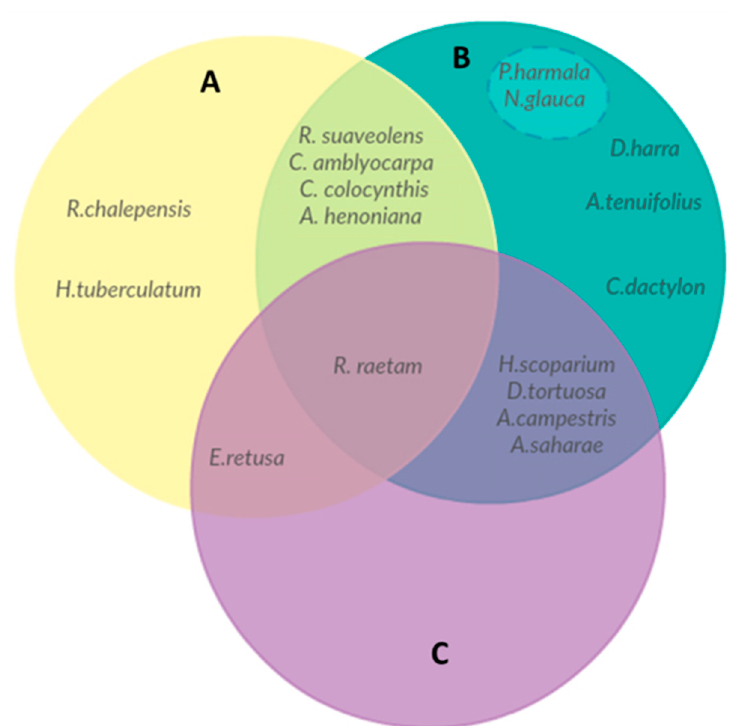
Figure 6. Overlap between ( A ) toxic taxa reported in this study, ( B ) taxa used by local communities of Ouled Dabbeb and reported by Le Floc’h [13] as toxic, and ( C ) plants reported as toxic but cautiously used.